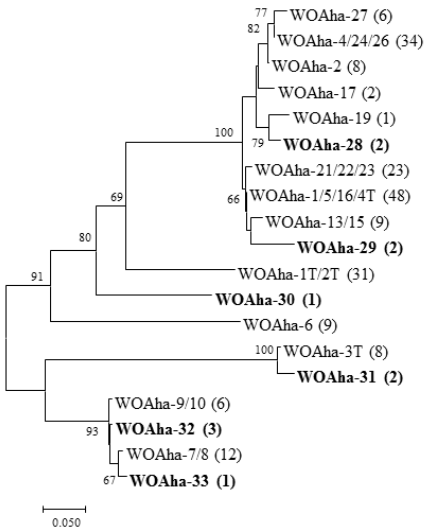
Figure 3. Maximum likelihood tree for phage WO types of A. hakonensis based on orf7 sequences obtain with new detection primers. The numbers in parentheses indicate the number of sequences obtained.